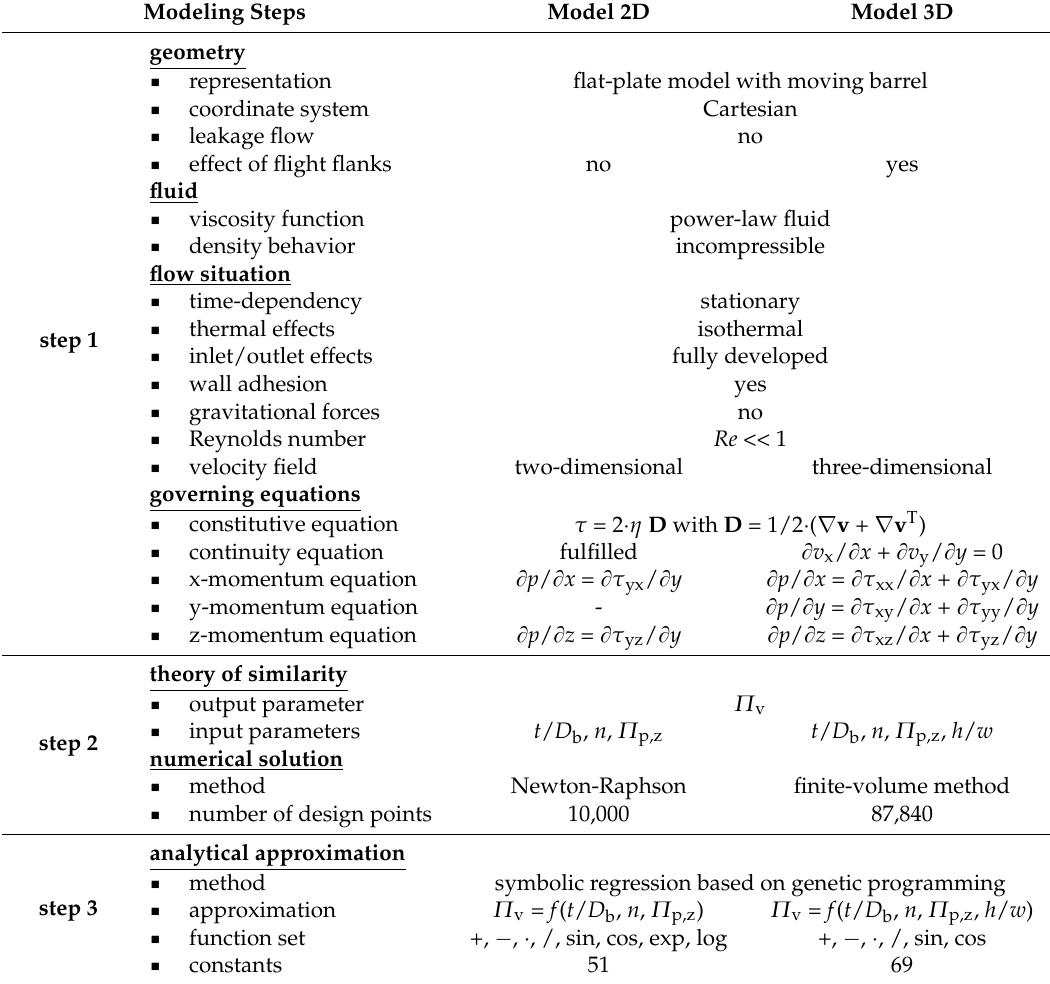
Table 6. Comparison of the heuristic melt-conveying